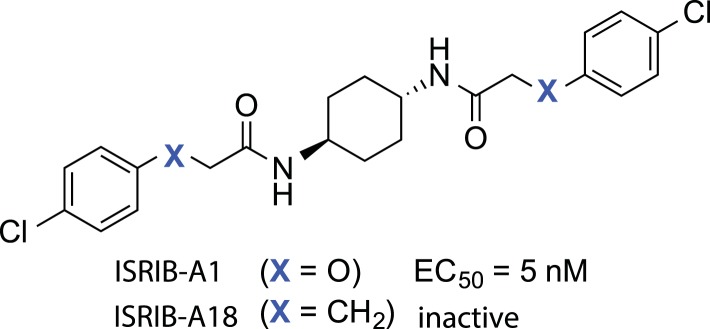
Structures of ISRIB (ISRIB-A1) and ISRIBinact (ISRIB-A18).